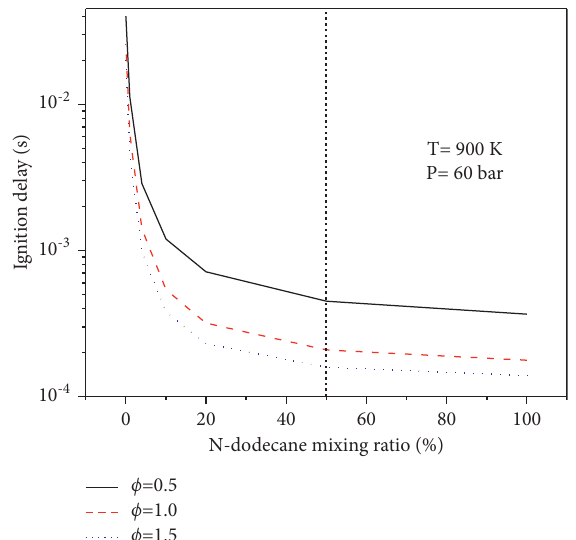
Figure 7: Ignition delay of different n-dodecane mixing ratios at an initial temperature of 900K and ϕ